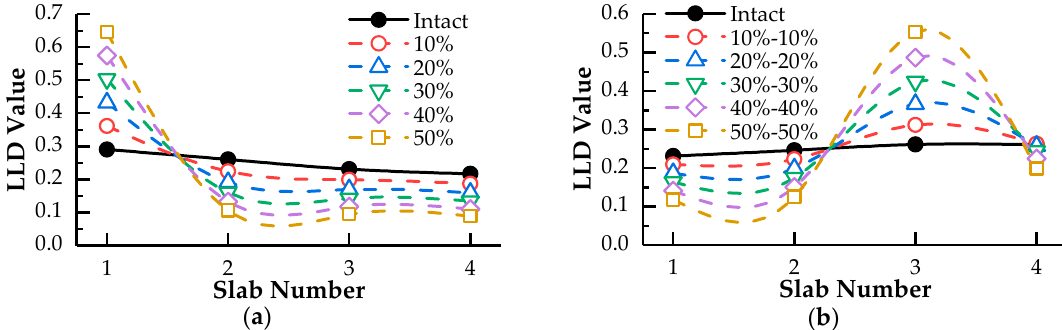
Figure 9. LLDs for a simply supported bridge with 4 slabs under different damage conditions: ( a ) LLD of slab 1 with hinge joint 1 damage; ( b ) LLD of slab 3 with hinge joints 2 and 3 damages.